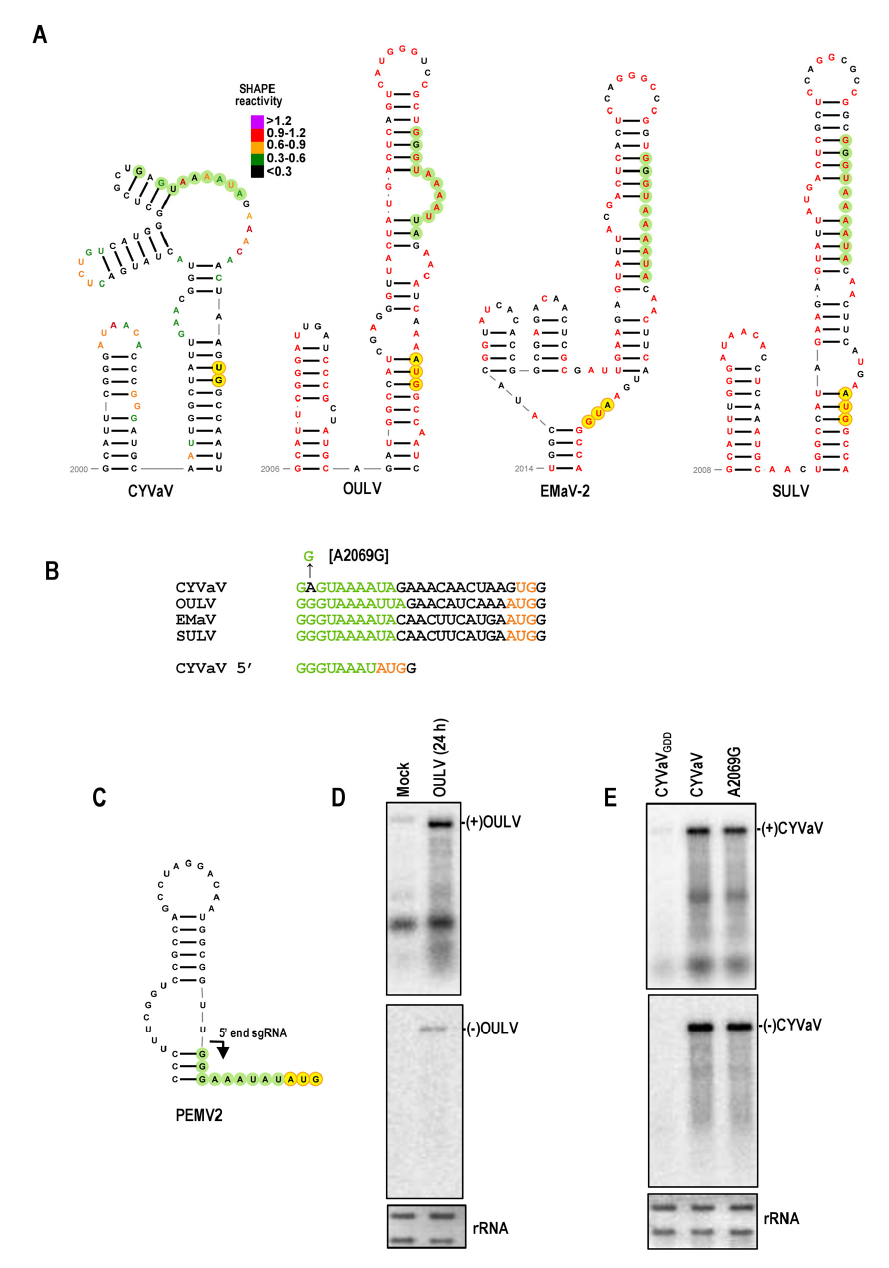
Figure 9. Comparison of the region encompassing the ORF5 start site. ( A ) SHAPE-derived Structure 11 in CYVaV and proposed structures for the other Class 2 ulaRNAs. SHAPE data is shown for the CYVaV structure. Red residues in the other proposed structures are conserved with CYVaV. CCS sequence is shaded green. Note that the CYVaV CCS is missing a conserved G residue. Translation initiation site for ORF5 is shaded yellow in OULV, EMaV and SULV. In CYVaV, the sequence is a “GUG” and the UG are shaded yellow. ( B ) Sequence of the Class 2 CCS (shown in A) compared with the 5 ′ end of CYVaV (5 ′ ). Base alteration in CYVaV mutant A2069G that generated a canonical CCS is shown. ( C ) Conserved structure in the vicinity of the mapped sgRNA from PEMV2 [66]. ( D ) Northern blot analysis of wild-type OULV accumulating in Arabidopsis protoplasts inoculated with full-length transcripts. OULV RNA levels were examined at 24 h post-inoculation by probing for (+)OULV (top) and ( − )OULV (bottom). Ethidium bromide-stained 28S rRNA was used as a loading control. ( E ) Northern blot analysis of CYVaV wild-type (CYVaV) and mutant transcripts. CYVaV GDD , CYVaV with a mutation in the RdRp active site. Alternation in A2069G is shown in ( B ). No sgRNA product was discernable for OULV or wild-type or mutant